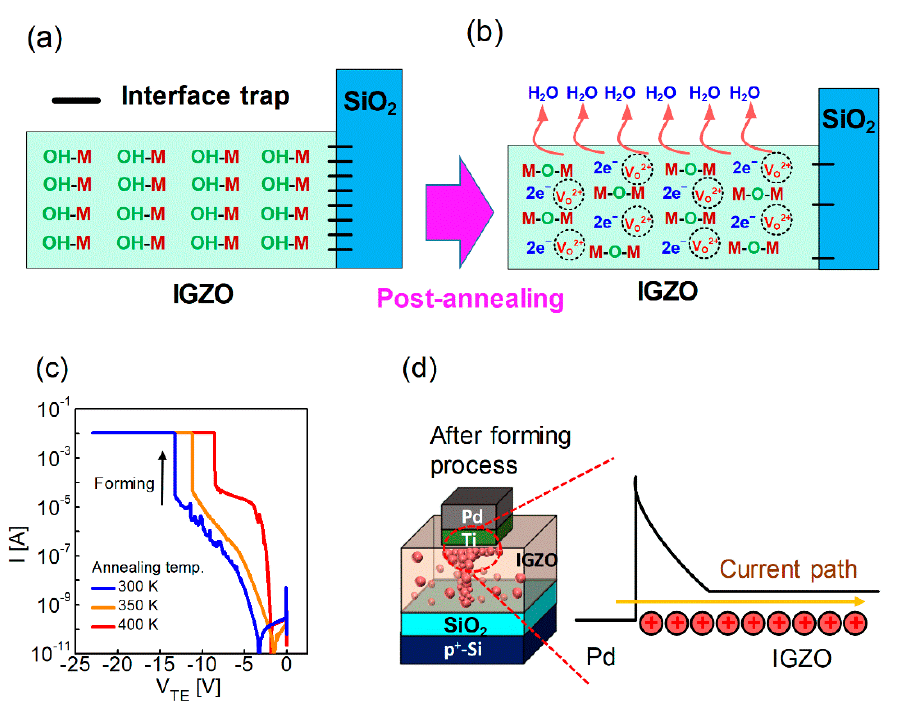
Figure 2. Illustration of O-H bond, H 2 O, oxygen vacancy, and electrons in IGZO and interface trap between the IGZO and SiO 2 layers ( a ) before and ( b ) after annealing; ( c ) I-V curves of forming process in the devices at different annealing temperatures (300, 350, 400 K); and ( d ) Schematic of oxygen vacancies in IGZO and simple band diagram of the Pd and IGZO layers.